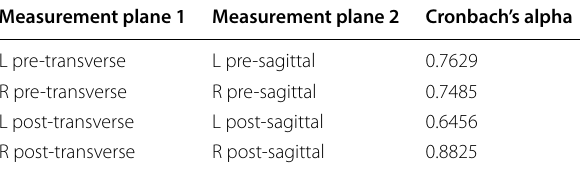
Table 6 Agreement of measurements between planes (transverse and sagittal) for each eye, pre- and post- lumbar puncture